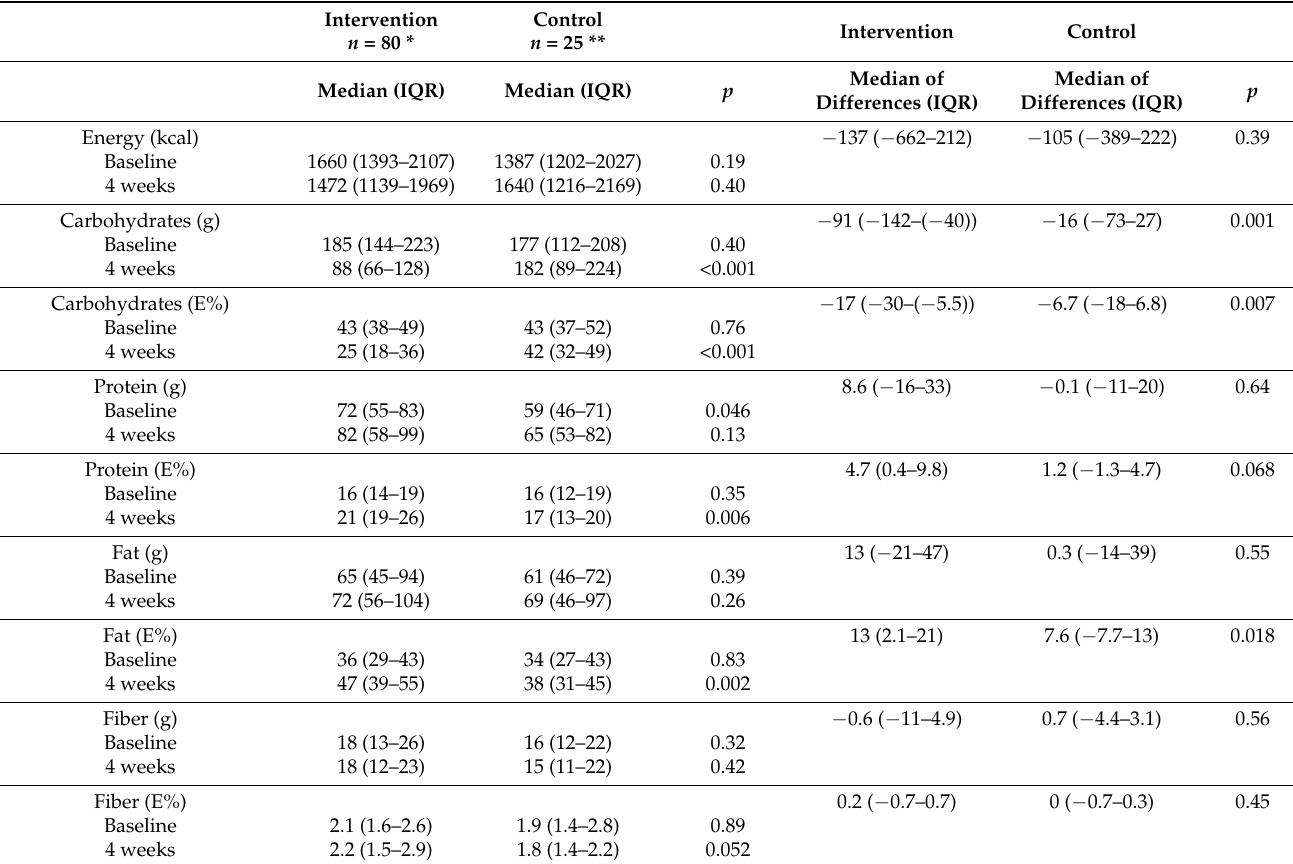
Table 2. Major food group and fiber intake before and after the 4-week SSRD intervention.